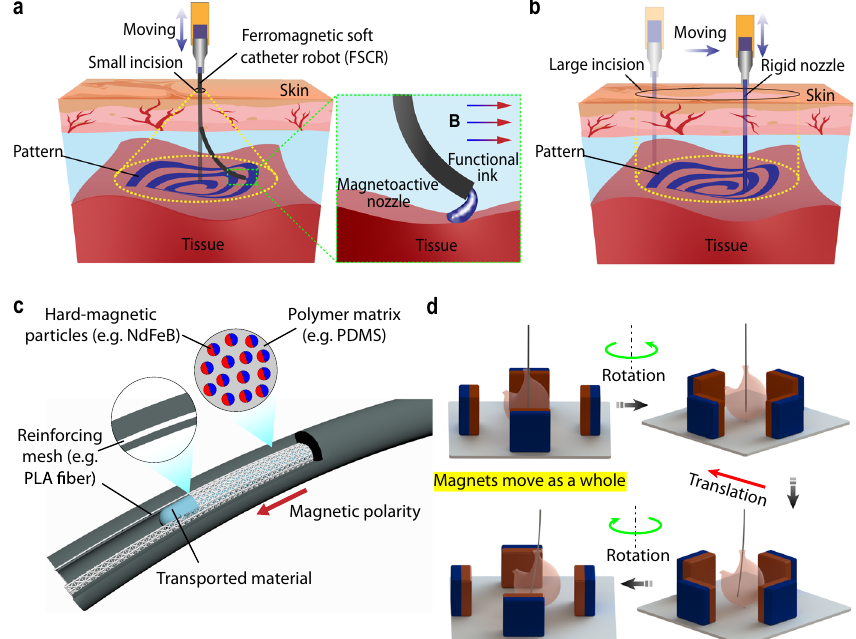
Fig. 1 Ferromagnetic soft catheter robot (FSCR) system for minimally invasive bioprinting. a Schematic illustration of the minimally invasive printing with functional inks (e.g., conducting polymer and living materials) inside the human body through a small incision; in the zoomed-in panel, B represents the magnetic fi eld. b Schematic illustration of the traditional printing system using a rigid nozzle with a large incision. c Schematic of FSCR that is composed of soft polymer matrix with dispersed hard-magnetic particles and polylactide (PLA) reinforcing mesh. The magnetic polarity is programmed along the FSCR axial direction. d The numerical control strategy of FSCR, where operations are instructed by digital data. Maneuvering of the FSCR via rotation and translation of the four permanent